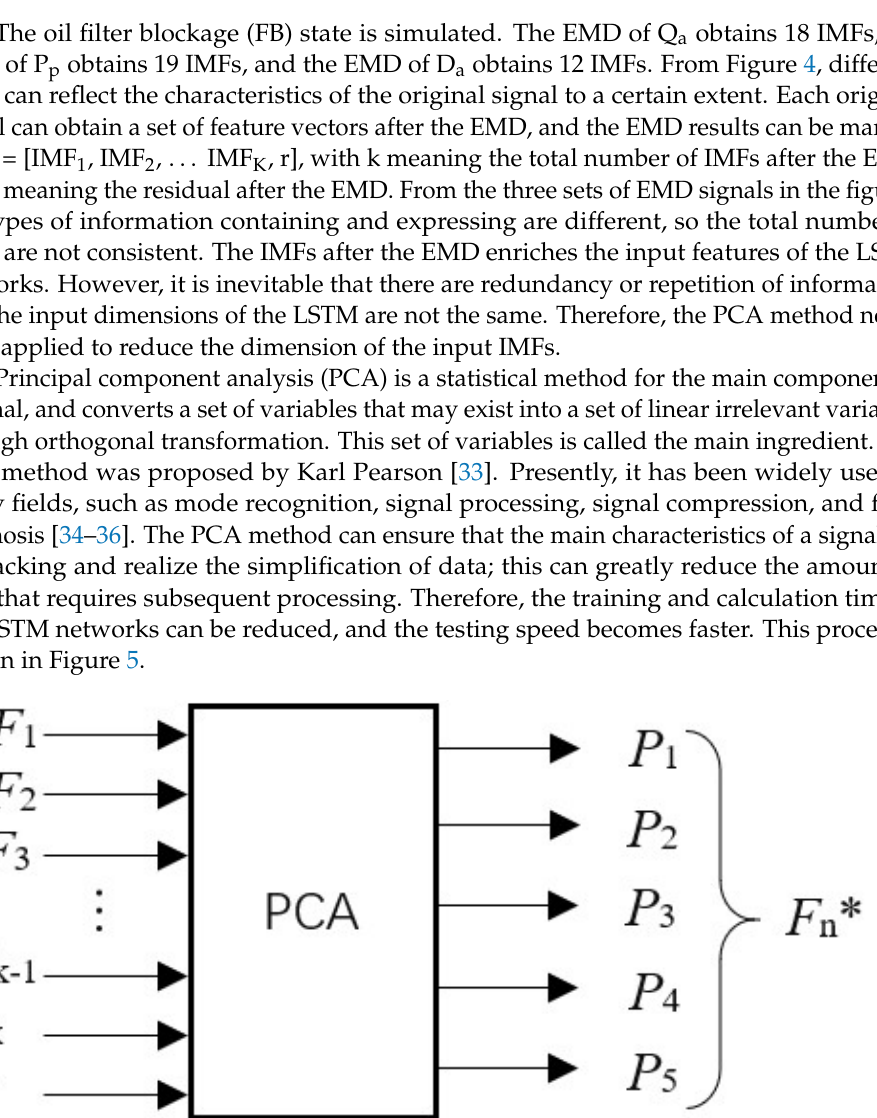
Figure 4. EMD results of different channel signals.